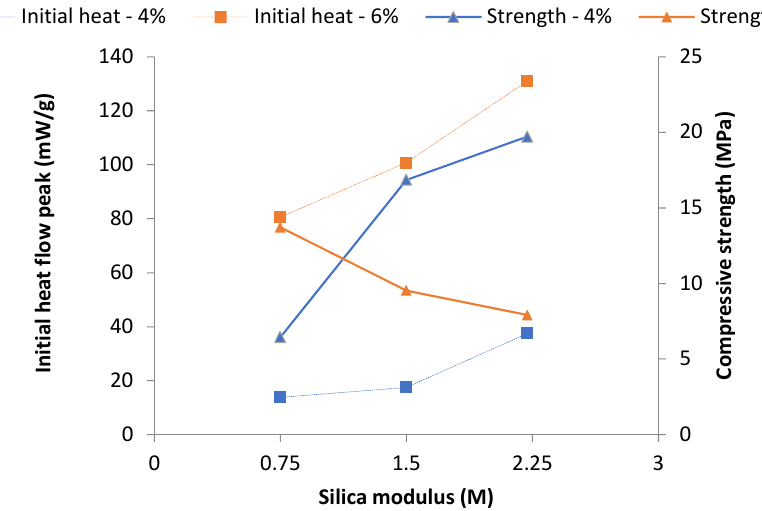
Figure 7. Influence of the activator parameters on the relation between the initial heat release and compressive strength (blue: 4% of Na 2 O; orange: 6% of Na 2 O; squares: initial heat release; triangles: compressive strength).